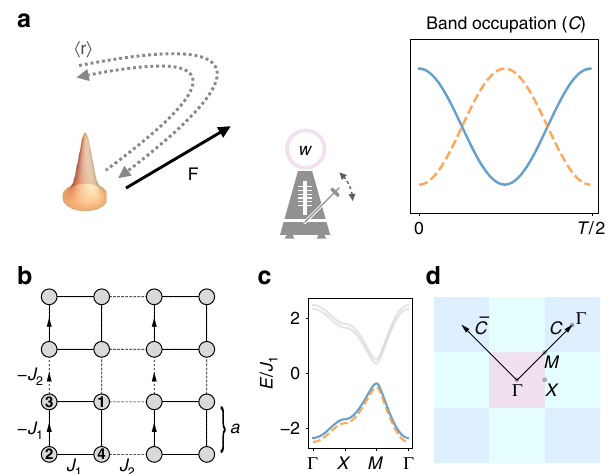
Fig. 1 Schematics of the non-Abelian topological BOs. a The center-of- mass position r h i of a gaussian wavepacket experiences a sign-changing Hall drift under the applied force F , while displaying a synchronized beating within two occupied bands. This synchronized effect, represented by the metronome, is topologically protected by the winding number w . b BBH model: a square lattice with π fl ux and staggered hopping amplitudes J 1 and J 2 . Vertical bonds with arrows correspond to a Peierls phase hopping amplitudes. c Band structure of the model. Each band is twofold degenerate. d Brillouin zones and paths C and (cid:2) C exhibiting topological